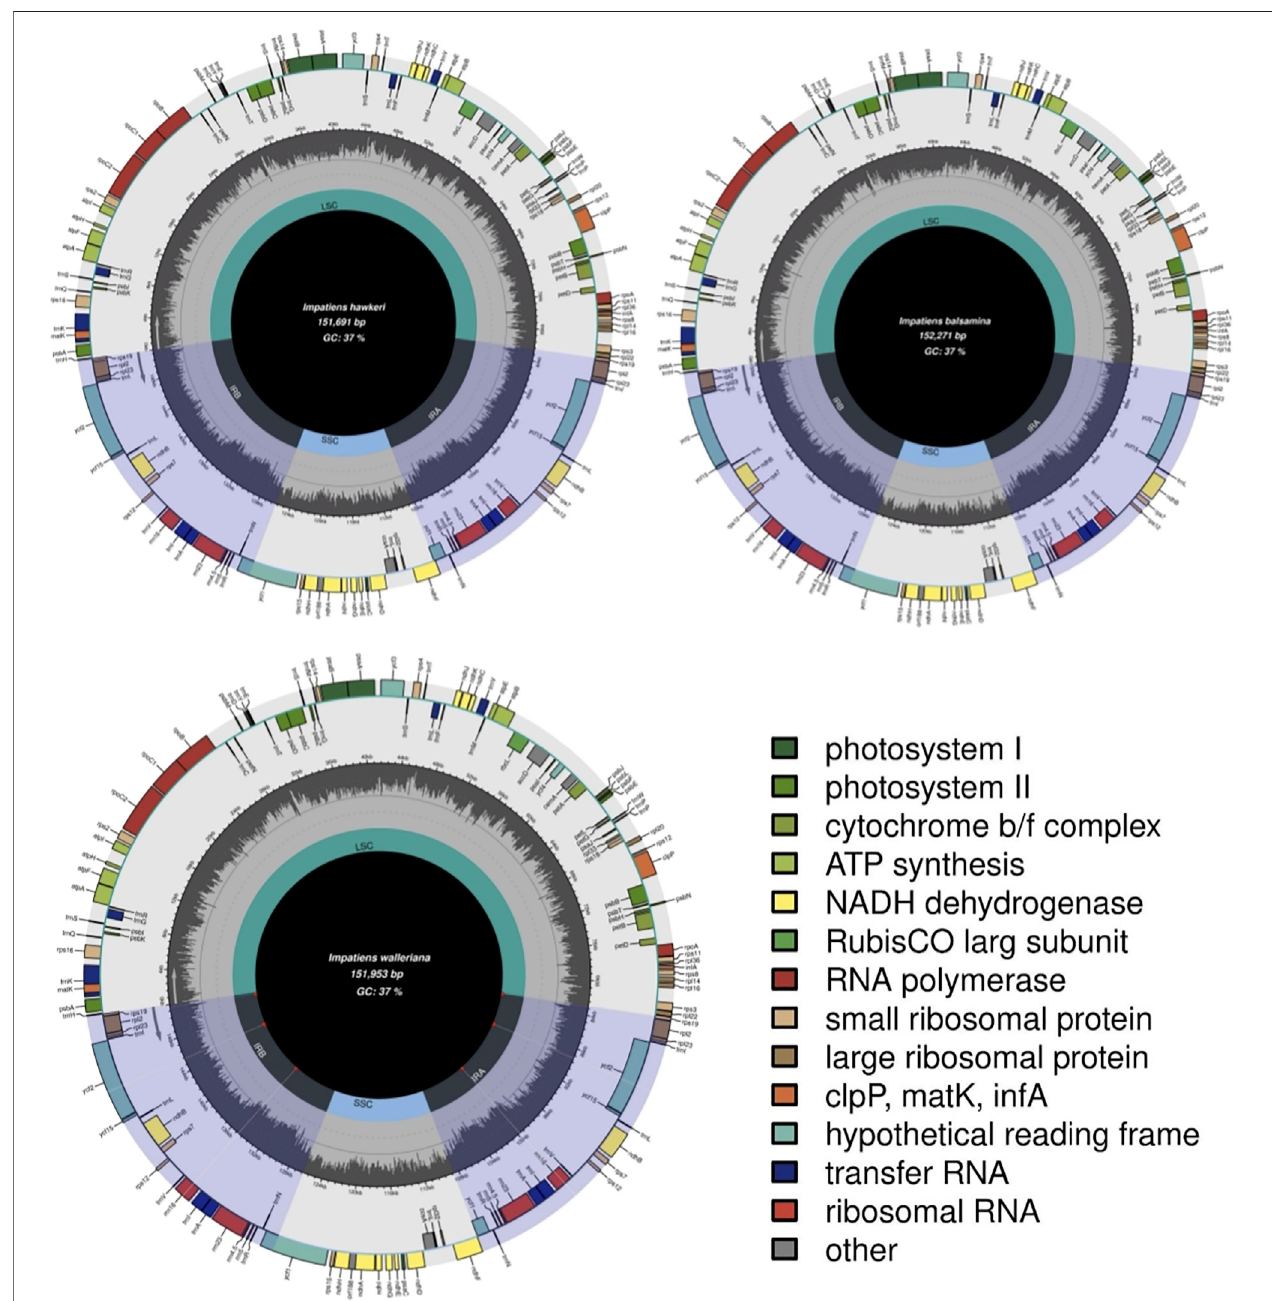
FIGURE 1 | Chloroplast genome structure of three Impatiens species ( I. balsamina, I. hawkeri, and I. walleriana ).